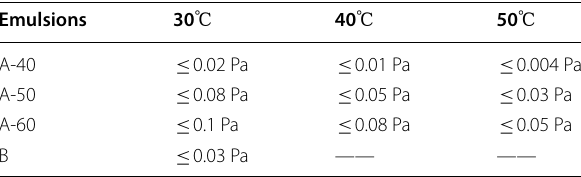
Table 3 Linear rheological region of the studied asphalt emulsions